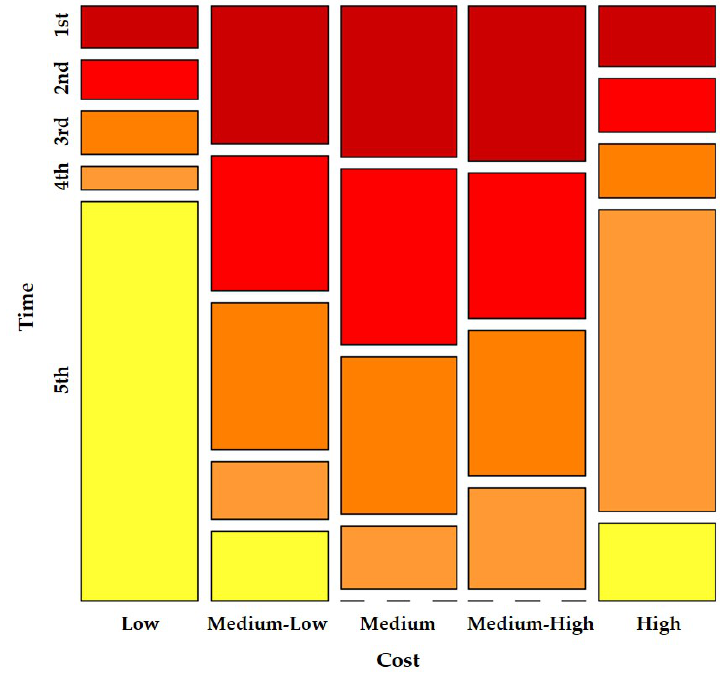
Figure 3. Graphical representation of the probability of executing a SC given the SCs’